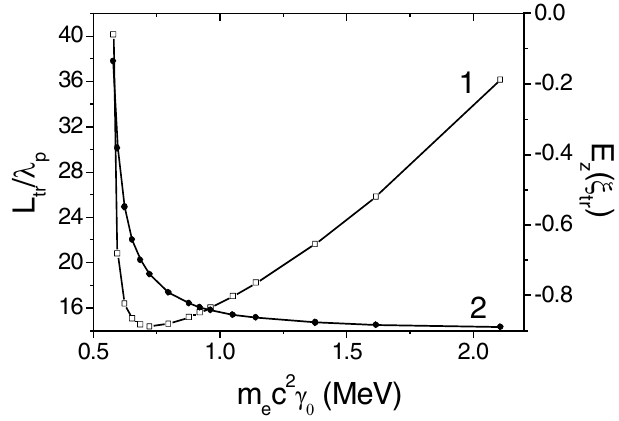
FIG. 5. The trapping distance normalized to the linear plasma wavelength (1) and the strength of the accelerating wakefield at the trapping point (2) depending on the initial energy of an electron; a (cid:4) 3 (cid:31) z